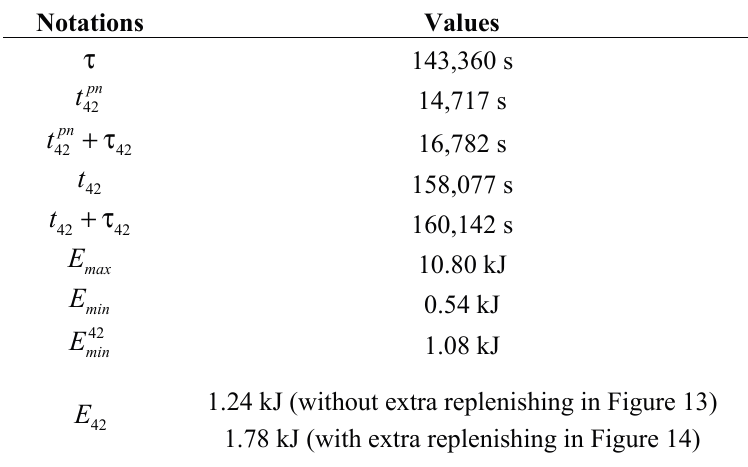
Table 5. Notations and their values in Figures 13 and